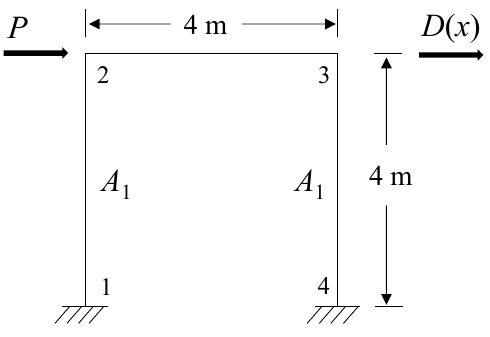
Table 6. Comparison of calculation results of Case 2.